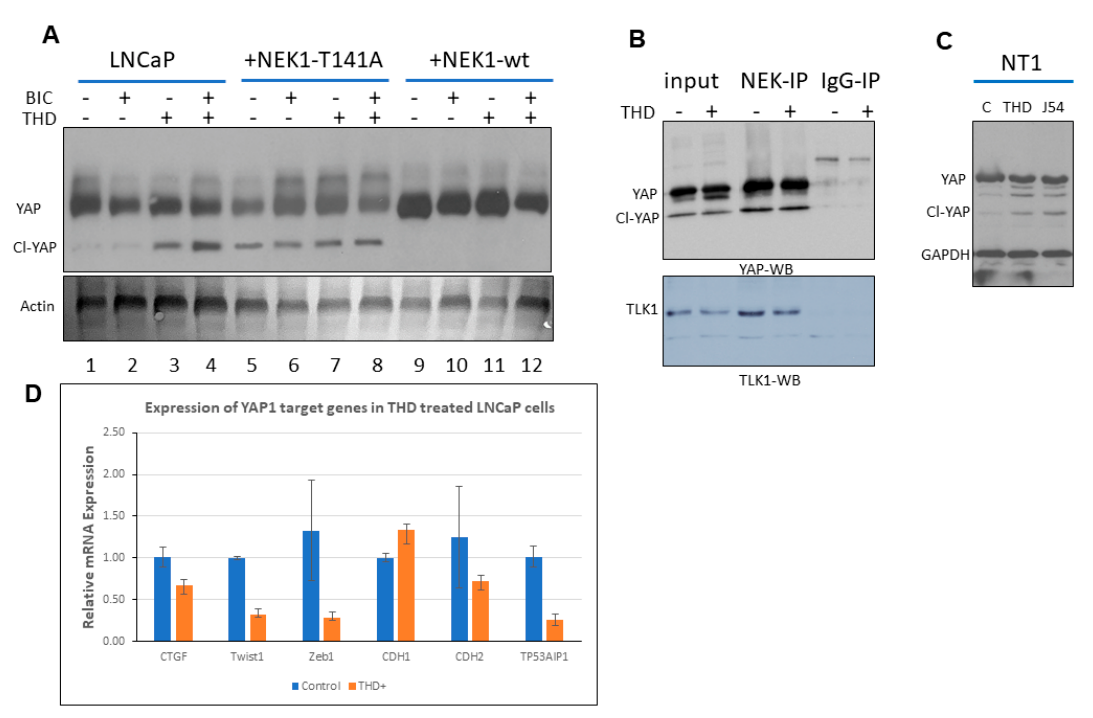
Figure 1. ( A ) The expression of yes-associated protein (YAP) was regulated by never in mitosis gene A (NIMA)-related kinases (NEK) activity and its upstream kinase tousled-like kinase (TLK). Overexpression of wt-NEK1 resulted in elevated YAP expression and conversely in its degradation in LNCaP cells overexpressing the dominant negative mutant NEK1-T141A. Thioridazine (THD) led to degradation of YAP in parental LNCaP cells, even after treatment with bicalutamide (BIC), which led to overexpression of TLK1B. ( B ) YAP interacted with NEK1 and was enriched upon co-immunoprecipitation. TLK1 inhibition with 10 µM THD did not affect NEK1 interaction with YAP, and thus the state of NEK1 kinase activity did not affect YAP binding. ( C ) The expression of YAP was decreased in NT1 cells treated with two different inhibitors of TLK (THD and J54), with a corresponding increase in CL-YAP products. ( D ) Expression of several typical YAP target genes in LNCaP cells treated with THD.